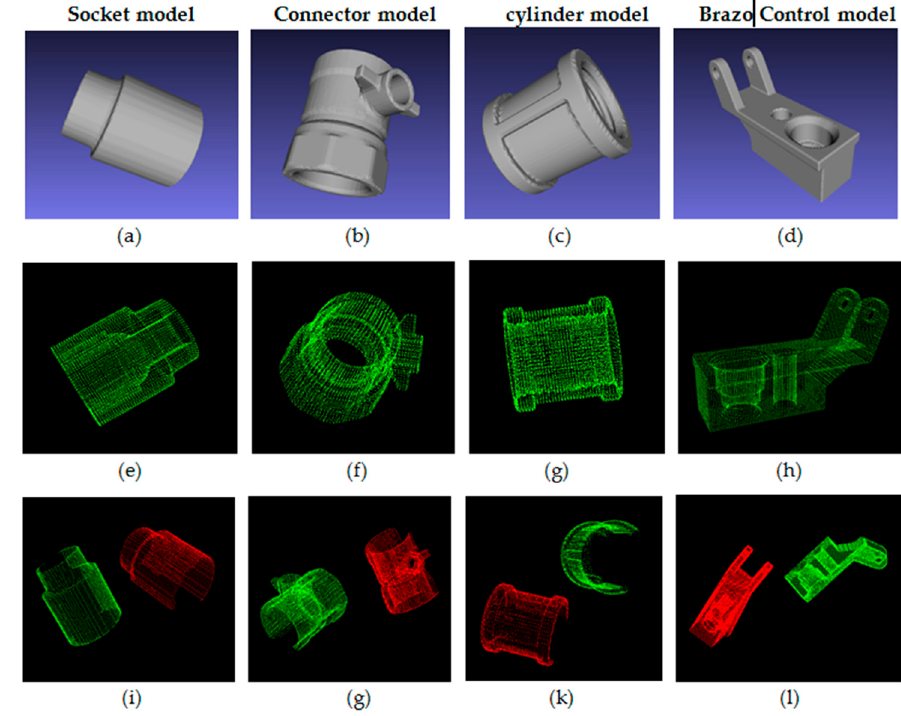
Figure 11. The synthetic data used in experiments: ( a – d ) CAD models of the objects; ( e – h ) point cloud of the objects; ( i – l ) point cloud of the objects from the virtual camera.